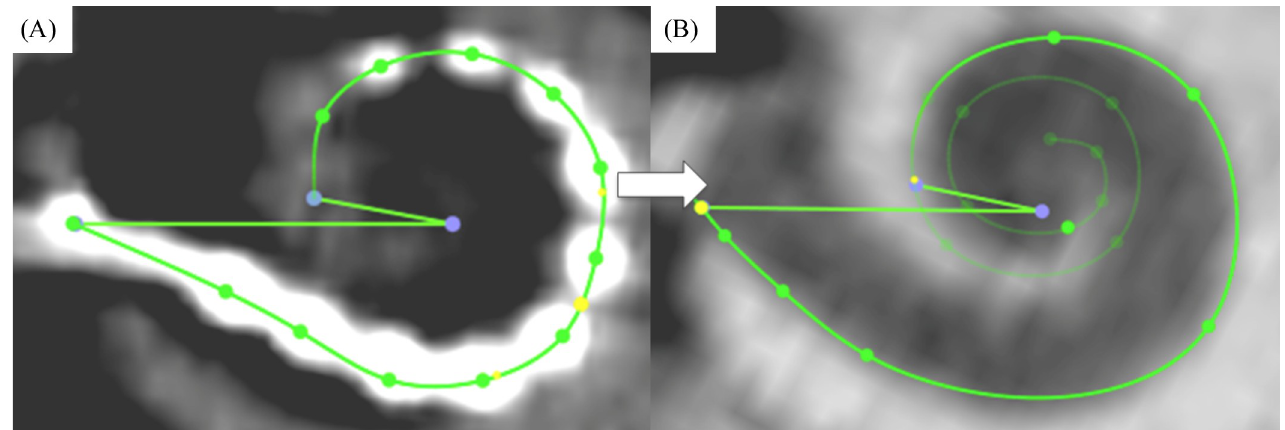
Fig 5. Inclusion of postoperative imaging analysis. (A) Postoperatively, marker points were placed in the center of the round window and along the inserted electrode array in the middle of the respective contact artefacts, and the corresponding insertion angle was measured. (B) The latter value was then used within the corresponding preoperative imaging data to determine the length along the lateral wall up to the insertion